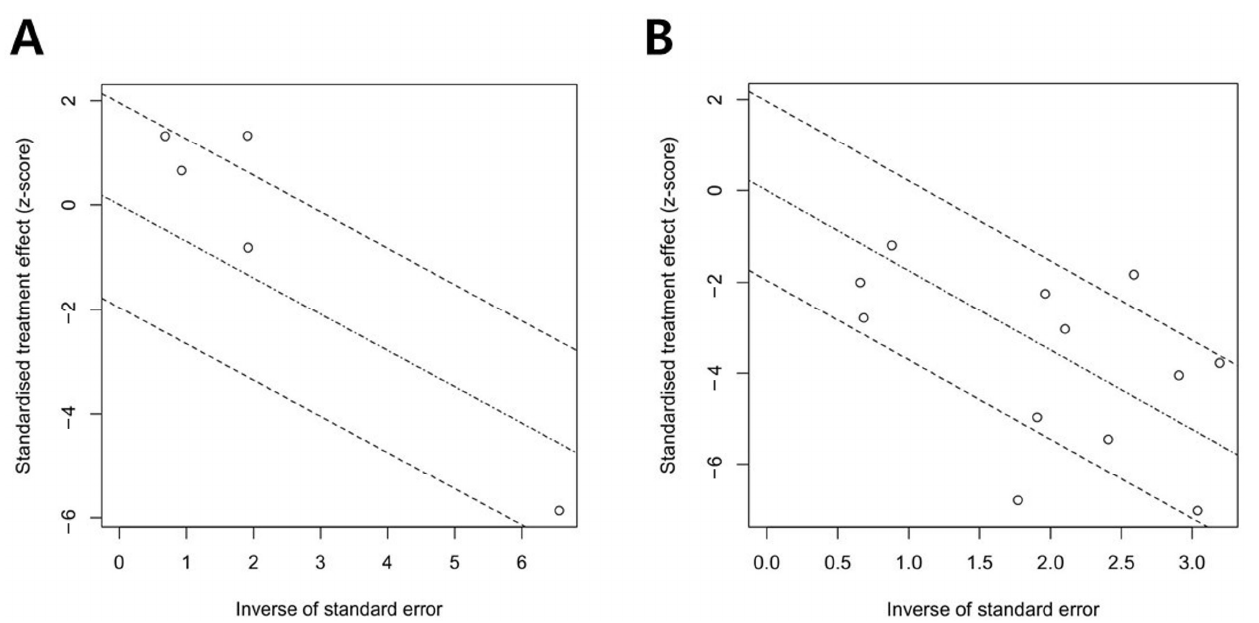
Figure 6. Radial plots of 5-year overall survival (OS) ( A ) and 5-year recurrence-free survival (RFS) ( B ). A little heterogeneity was noted in radial plots.